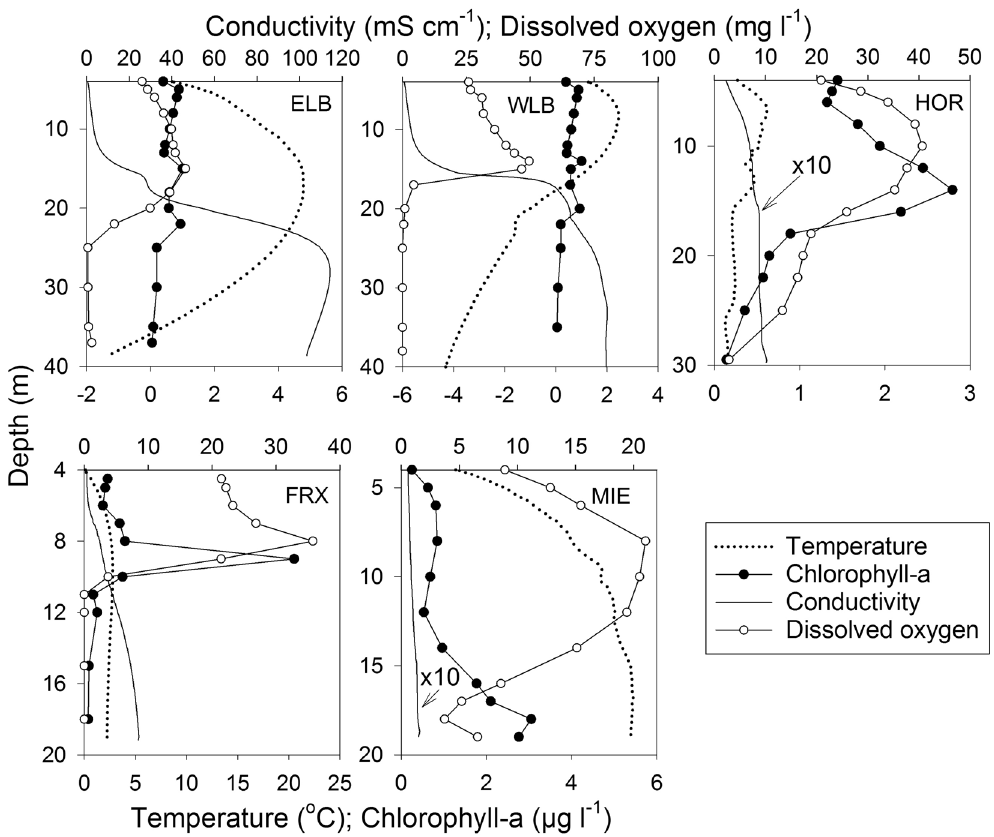
Figure 2. Profiles of conductivity, temperature, chlorophyll-a, and dissolved oxygen in the five lake basins studied during December 2011. All profiles begin at the ice-water interface. ELB: Lake Bonney East lobe, WLB: Lake Bonney West lobe, FRX: Lake Fryxell, HOR: Lake Hoare, MIE: Lake Miers. Note that the actual conductivity values presented for Lakes Hoare and Miers were multiplied by 10 to increase their visibility on the graph. Their actual values are 10 times lower than shown, revealing the freshwater nature of these two lakes relative to the